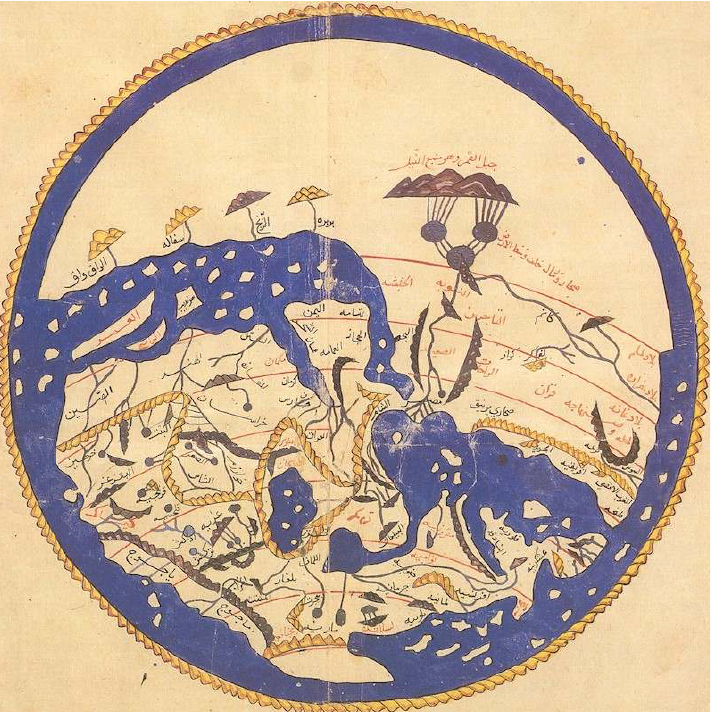
The map is centred on the Arabian Peninsula at the crossroads between the two bodies of water. Note the southern orientation of the map. Source: https://commons.wikimedia.org/wiki/File:1154_world_map_by_Moroccan_cartographer_al-